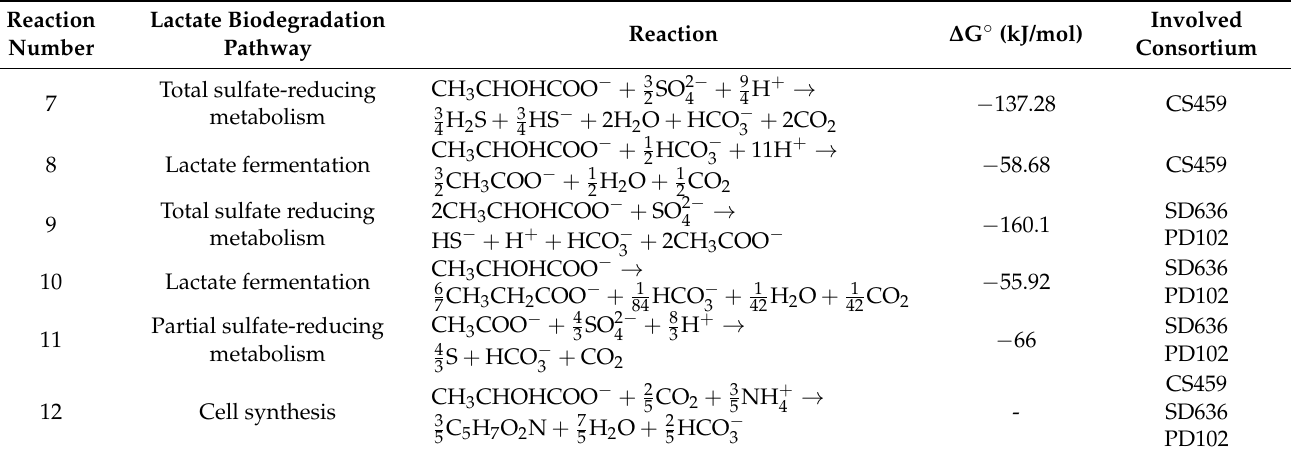
Table 4. Lactate biodegradation pathways used in the mass and electron balances with the SC469, SD636 and PD102 consortia using sulfate-reducing and fermentative microorganisms.